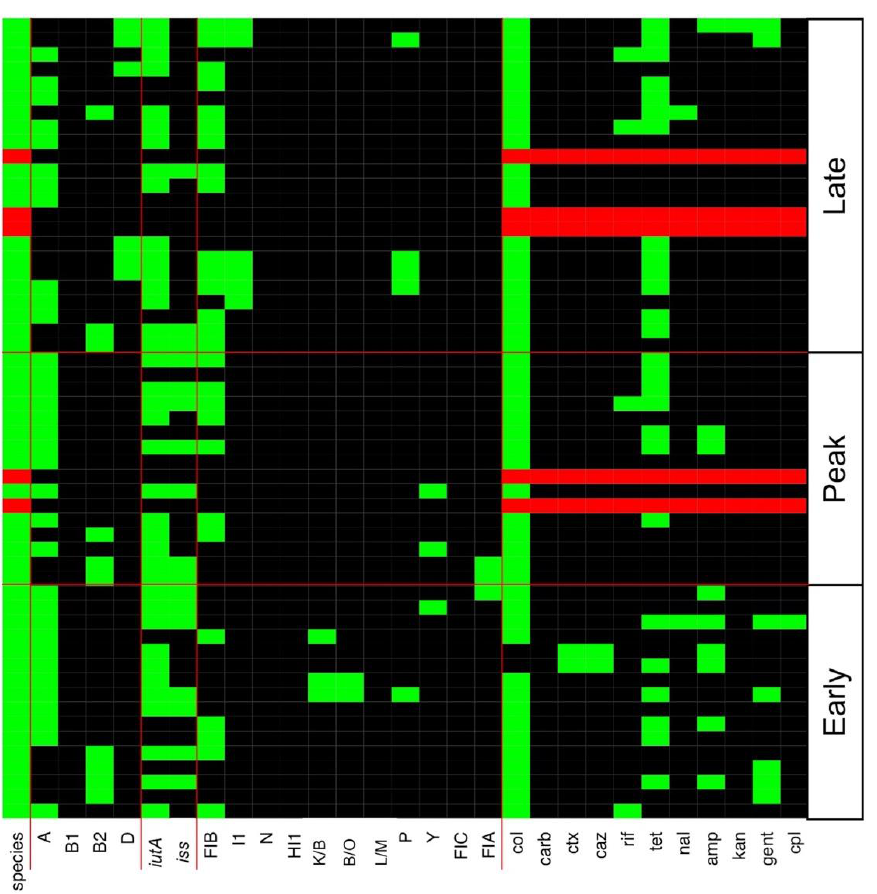
Figure 4. Heatmap of genes and phenotypes detected in cage-free antibiotic resistant isolates. All positive E. coli results are shown in the heatmap as green. All positive Acinetobacter spp. are shown as red. Negative results are shown in black in the heatmap. Col, colistin; carb, carbapenem; ctx, cefotaxime; caz, ceftazidime; rif, rifampicin; tet, tetracycline; nal, nalidixic acid; amp, ampicillin; kan, kanamycin; gent, gentamicin; cpl, chloramphenicol.